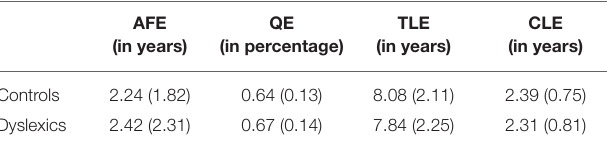
TABLE 1 | Means (SDs) of bilingual children’s exposure to